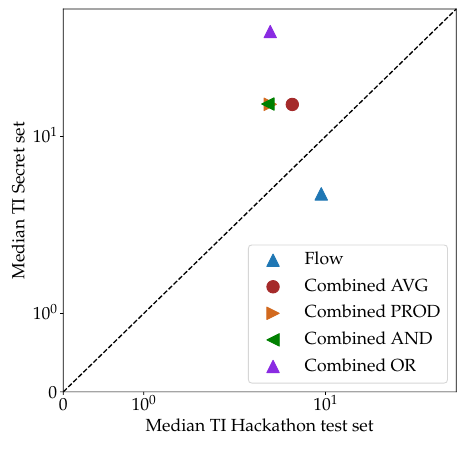
Figure 4: Comparison of the median TI between the hackathon test set and the secret set. While the performance of the flow model is worse on the secret set, the combined models do much